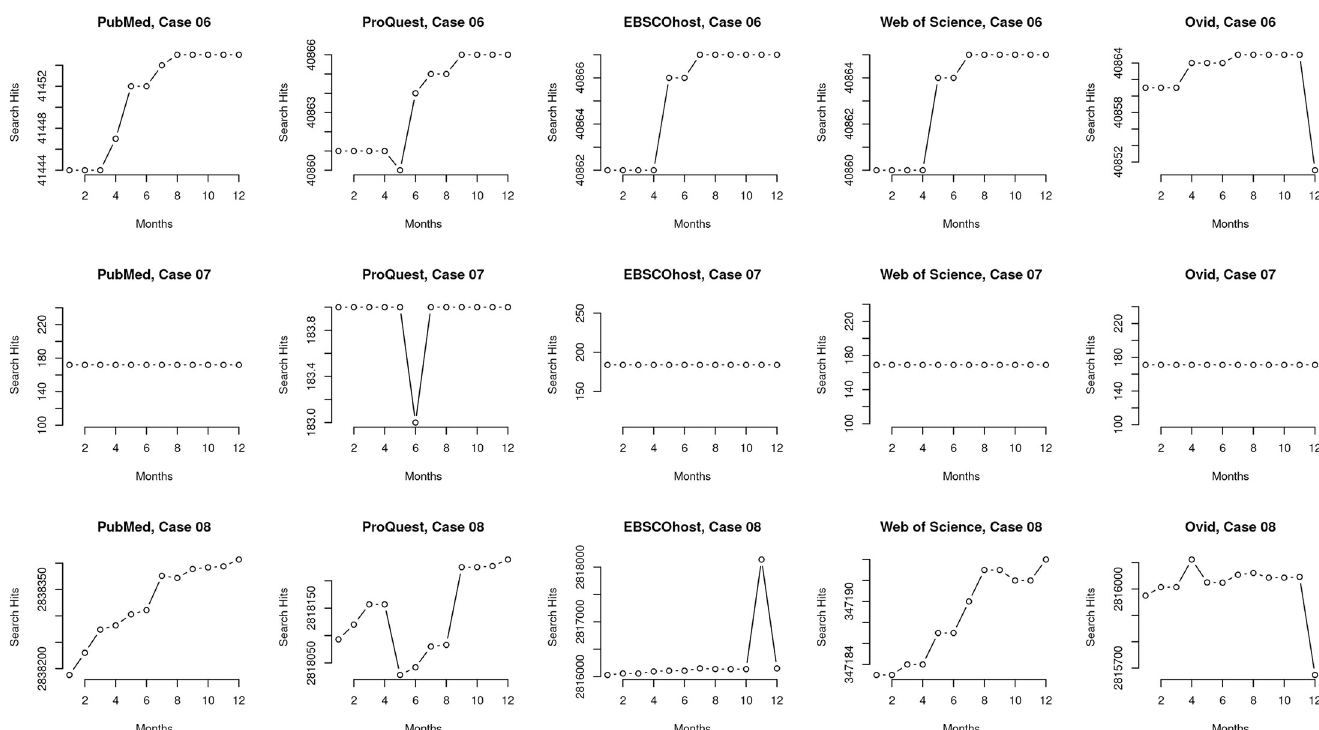
Fig 5. Micro view of cases #03–#11. A micro perspective of search result counts for cases #03-#11 that were restricted by publication date. Each row displays all five platforms individually within a case to aid side by side comparison of results. The micro perspective is able to show how the platforms vary in detail and trends; most importantly, they highlight different trajectories and differences in how platforms drop retrieved records even for publications with publication dates ending years before data collection.